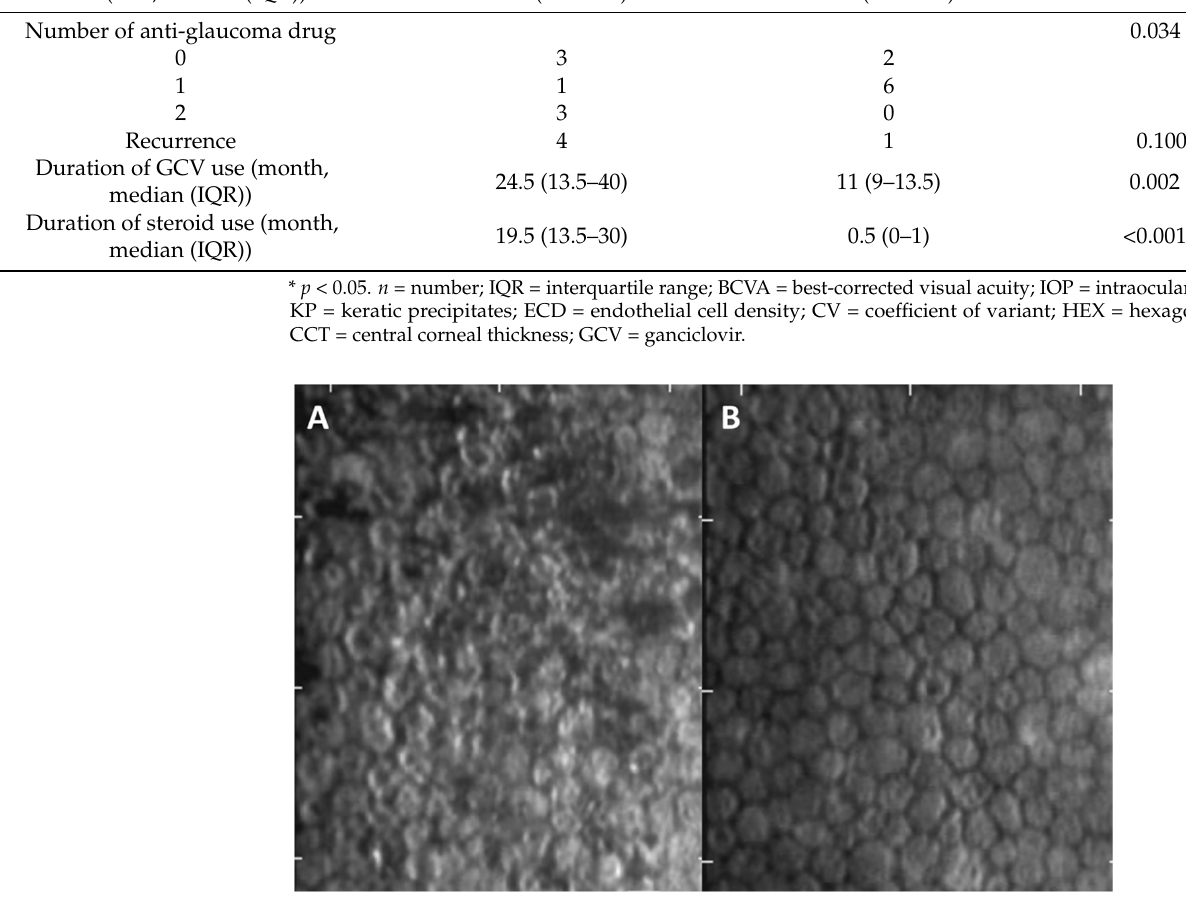
Figure 2. Specular microscopy of case 7. ( A ) Before treatment, the corneal endothelium showed numerous dark cells as pseudoguttata. The endothelial cell density (ECD) was 2331 cell/mm 2 , with marked pleomorphism and polymegathism. ( B ) After ganciclovir treatment, the ECD increased to 2500 cell/mm 2 , and the coefficient of variation value and hexagonal ratio improved from 51% to 43% and 33% to 43%, respectively.